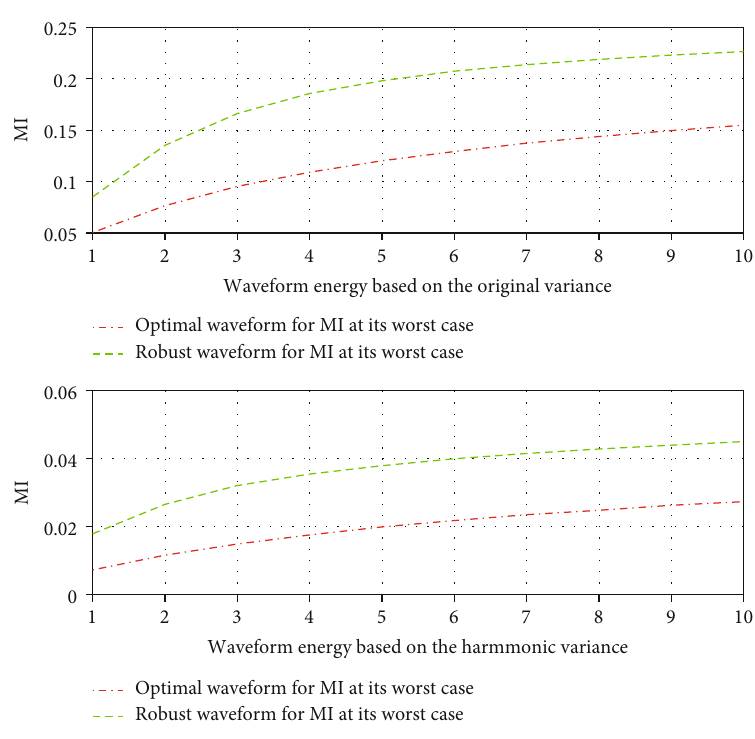
Figure 8: MI comparison of fi ve targets based on original variance and harmonic